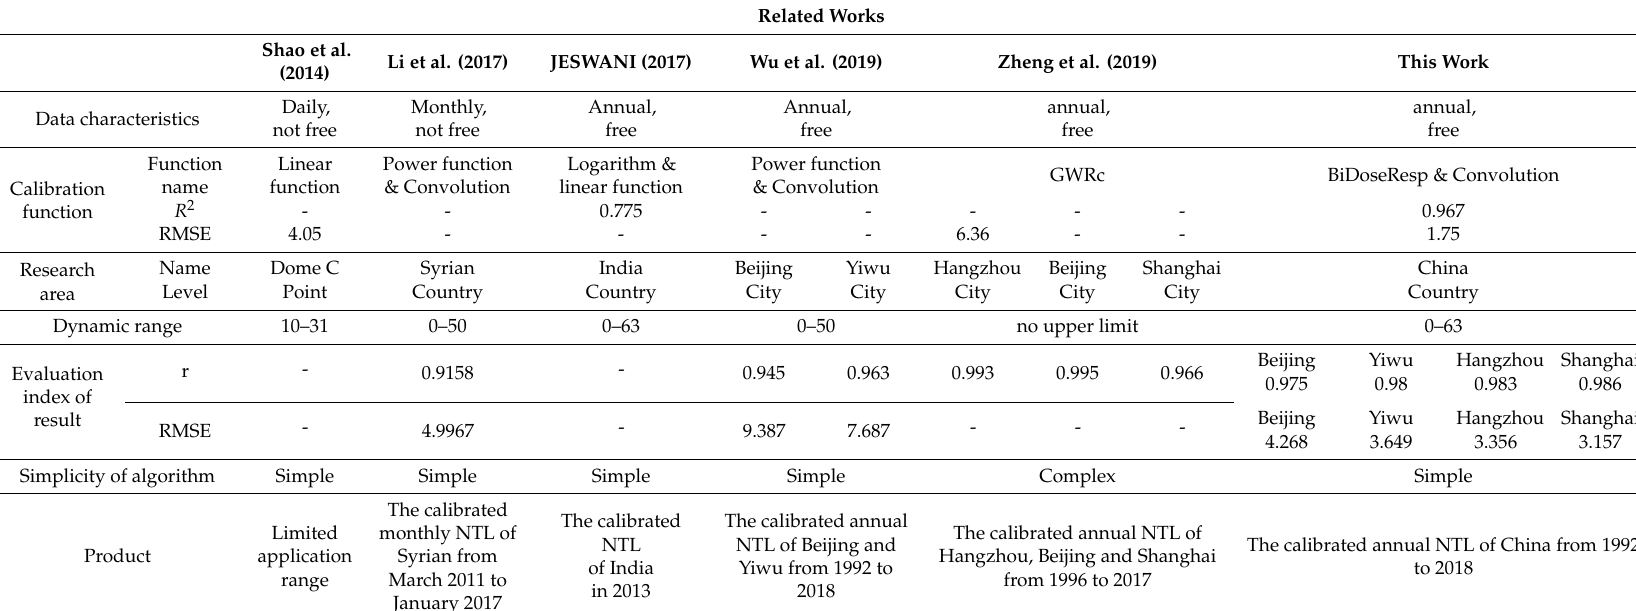
Table 4. Available information about the related